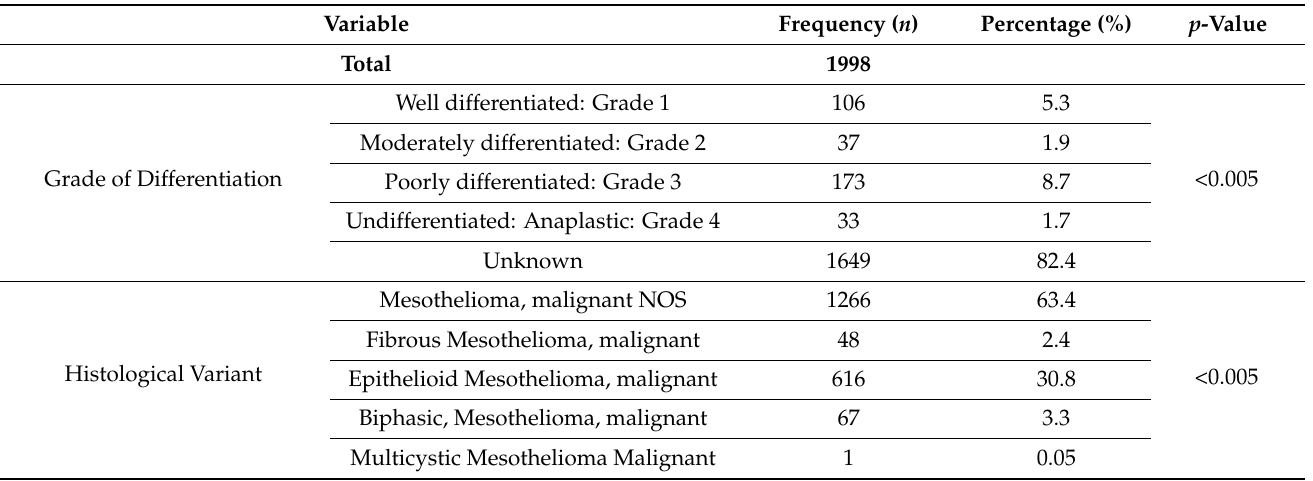
Table 2. Tumor Characteristics of 1998 Patients with Primary Peritoneal Mesothelioma from the Surveillance, Epidemiology, and End Results (SEER) database,